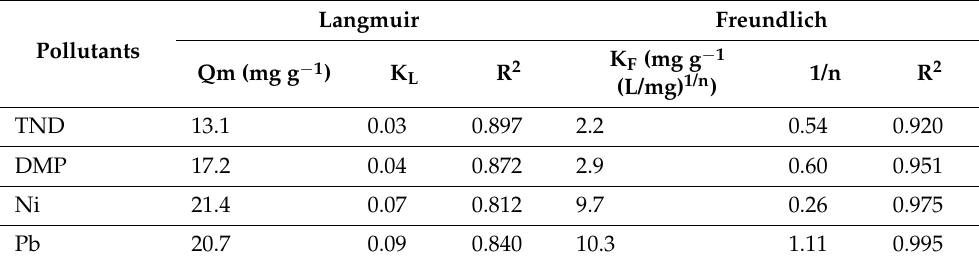
Table 5. Details of Langmuir and Freundlich isotherm